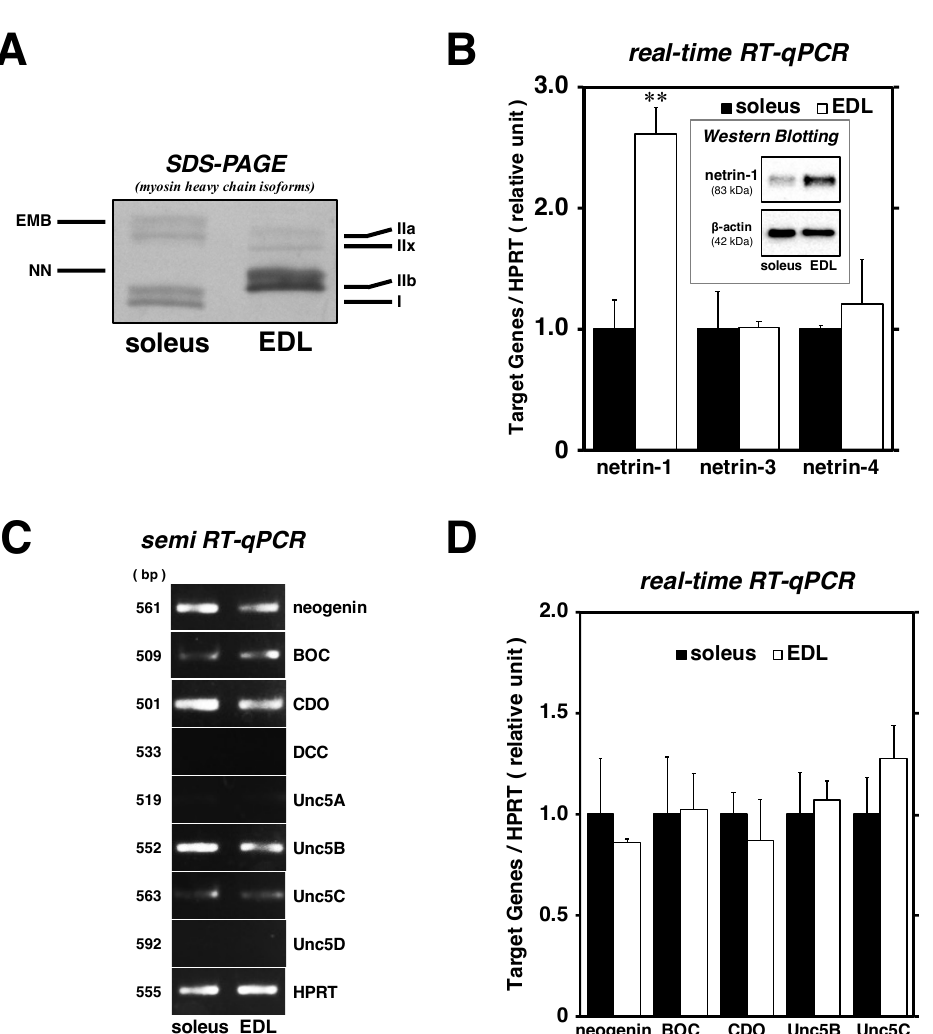
Figure 3. Comparative analysis of netrin expression levels in EDL and soleus muscle-derived satellite cells. (panel A ) Statues of soleus and EDL muscle; myofiber type composition of the skeletal muscle. MyHC isoforms (myofiber type; I [slow-twitch], IIa [intermediate], and IIx and IIb [fast-twitch]) were separated using SDS polyacrylamide gel electrophoresis (SDS-PAGE) of whole muscle samples (100 ng protein) and then visualized by silver staining. (panel B – D ) Proliferated satellite cells from soleus and EDL muscles were maintained in differentiation medium until 72 h. (panel B and D ) The cell lysates were evaluated for the mRNA expression of netrin-1, -3, and -4, neogenin, BOC, CDO, Unc5B, and Unc5C by real-time RT-qPCR standardized to HPRT expression. The bars depict the mean ± SEM of three independent cultures by relative units. (panel B inset) Netrin-1 protein expression by Western Blotting standardized to β -actin expression. (panel C ) The cell lysates were analyzed for the expression of netrin receptors (neogenin, BOC, CDO, DCC, Unc5A, Unc5B, Unc5C, and Unc5D) by routine RT-semiquantitative PCR standardized to HPRT level. Significant differences from satellite cells from soleus (black bars) at p < 0.01 are indicated by double asterisks. EMB : embryonic isoform; NN : neonatal